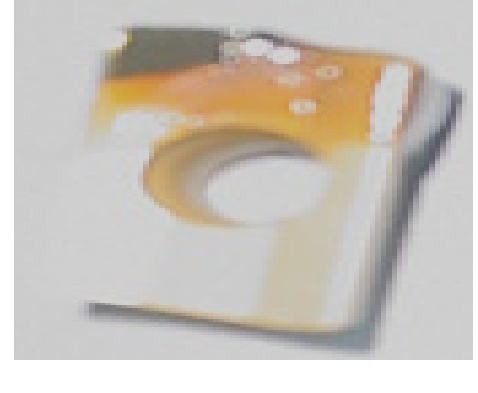
Figure 11. Carbide insert Figure 12. Diamond insert Before implementation After